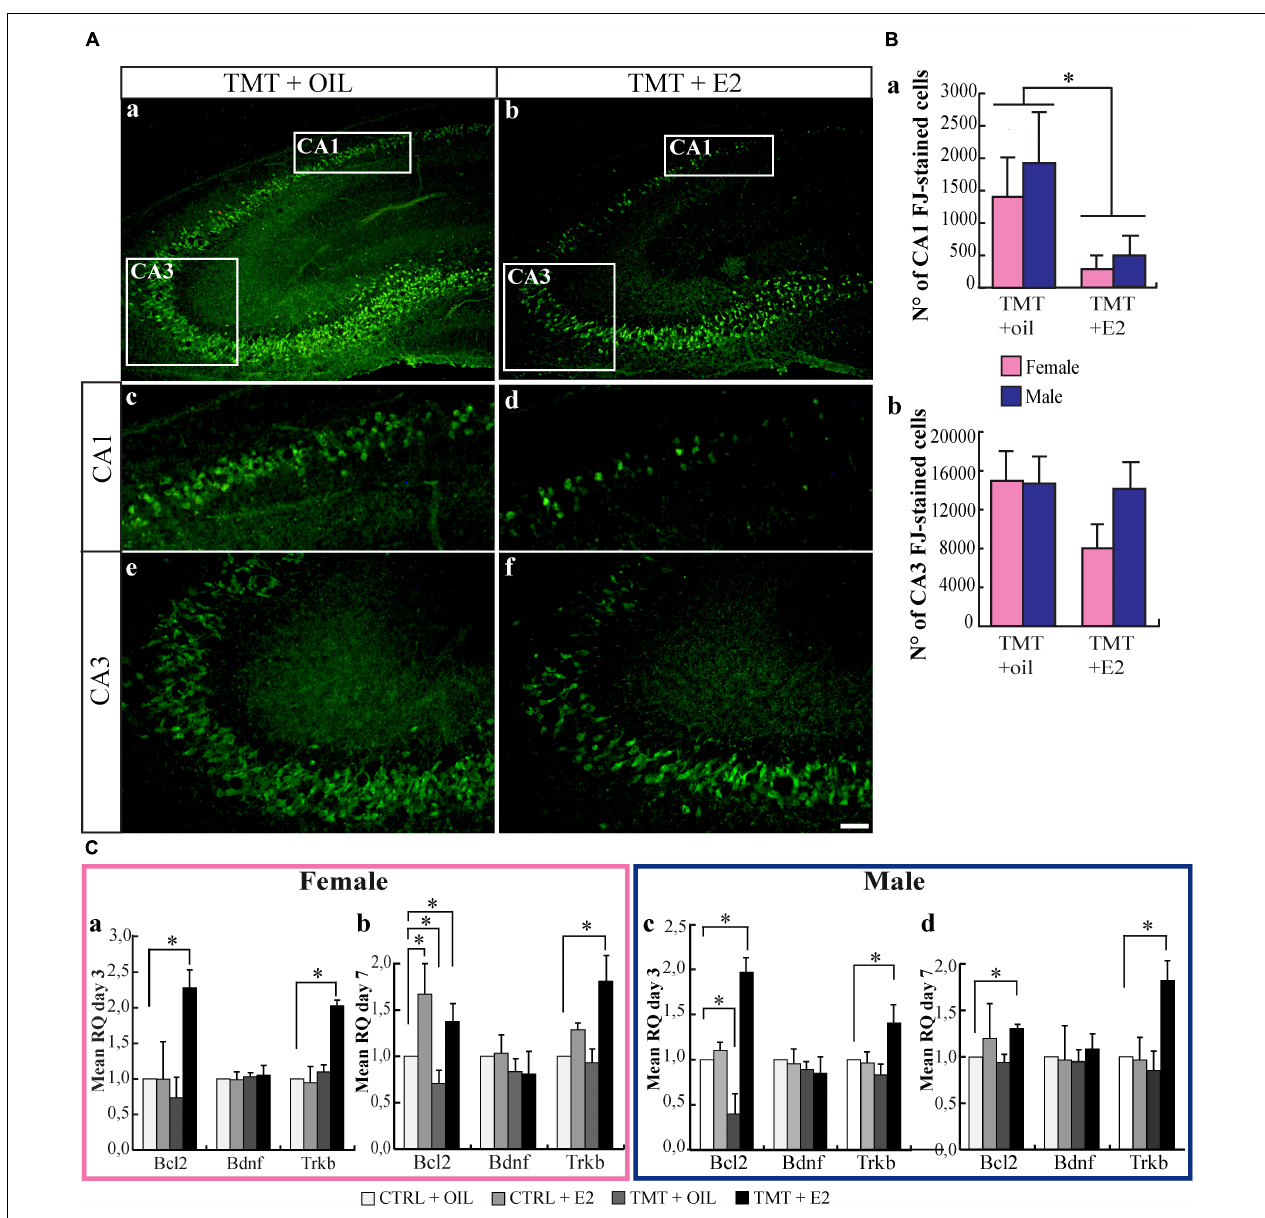
FIGURE 1 | (A) 17 β -estradiol (E2) reduces Fluoro Jade C (FJ)-stained degenerating neurons in the trimethyltin (TMT)-injured hippocampus. Representative micrographs of FJ-stained hippocampal sagittal sections (a,b) from CA1 (c,d) and CA3 subfields (e,f) of TMT+oil- (a,c,e) , and TMT+E2- (b,d,f) treated rats. FJ-positive neurons are clearly less numerous in the CA1 pyramidal layer of TMT+E2-treated animals compared with TMT+oil-treated rats. Scale bar: 250 µ m in (a,b) , 150 µ m in (c–f) . (B) Quantitative analysis of FJ -stained cells in the different experimental groups. Stereological cell counts of FJ-stained cells confirmed that both groups of TMT+E2-treated animals showed fewer degenerating neurons in CA1 compared with TMT+oil-treated groups. Two-way ANOVA revealed a significant effect of E2 treatment in CA1 ( F 1 , 17 = 5.68, Tukey post hoc p < 0.05) (a) . On the contrary, no significant difference was detectable in the CA3 subfield ( F 1 , 17 = 1.7; p > 0.05) (b) . No differences related to sex are present ( p > 0.05 both in CA3 and in CA1). The values are given as means ± SE ( ∗ p < 0.05) (F-TMT n = 6; M-TMT+oil n = 4; F-TMT+E2 n = 7; M-TMT+E2 n = 4). (C) Expression levels of genes involved in neuroprotective pathways and their modulation in the hippocampus of TMT-treated rats by E2 administration. Bar graphs represent results of quantitative real-time PCR obtained using the (cid:49)(cid:49) Ct method for the calculation of relative quantity (RQ), calculated on mean (cid:49) Ct across biological replicates, of Bcl-2 , Bdnf and trkB , 3 (a,c) and 7 (b,d) days after TMT treatment both in female (a,b) and male (c,d) rats ( ∗ p < 0.05) ( n = 4/each experimental